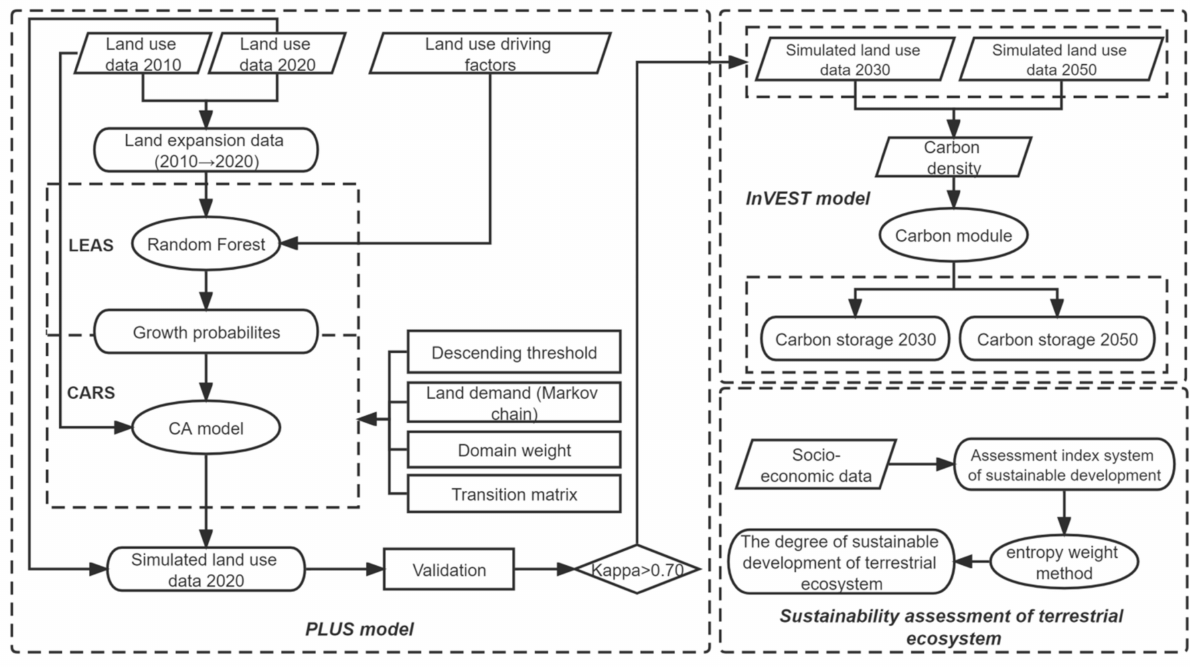
Figure 2. Flow chart of this